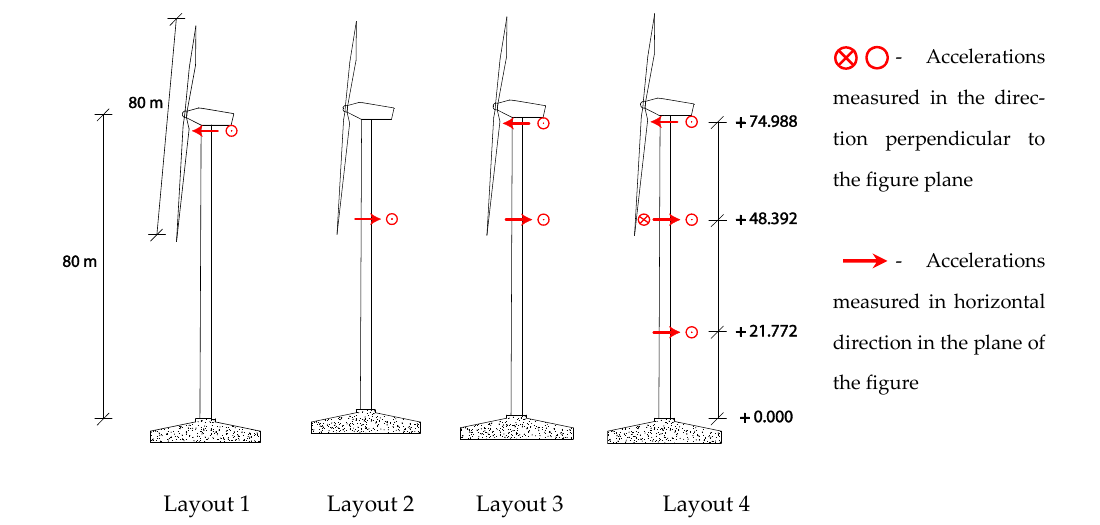
Figure 4. Alternative sensor layouts.